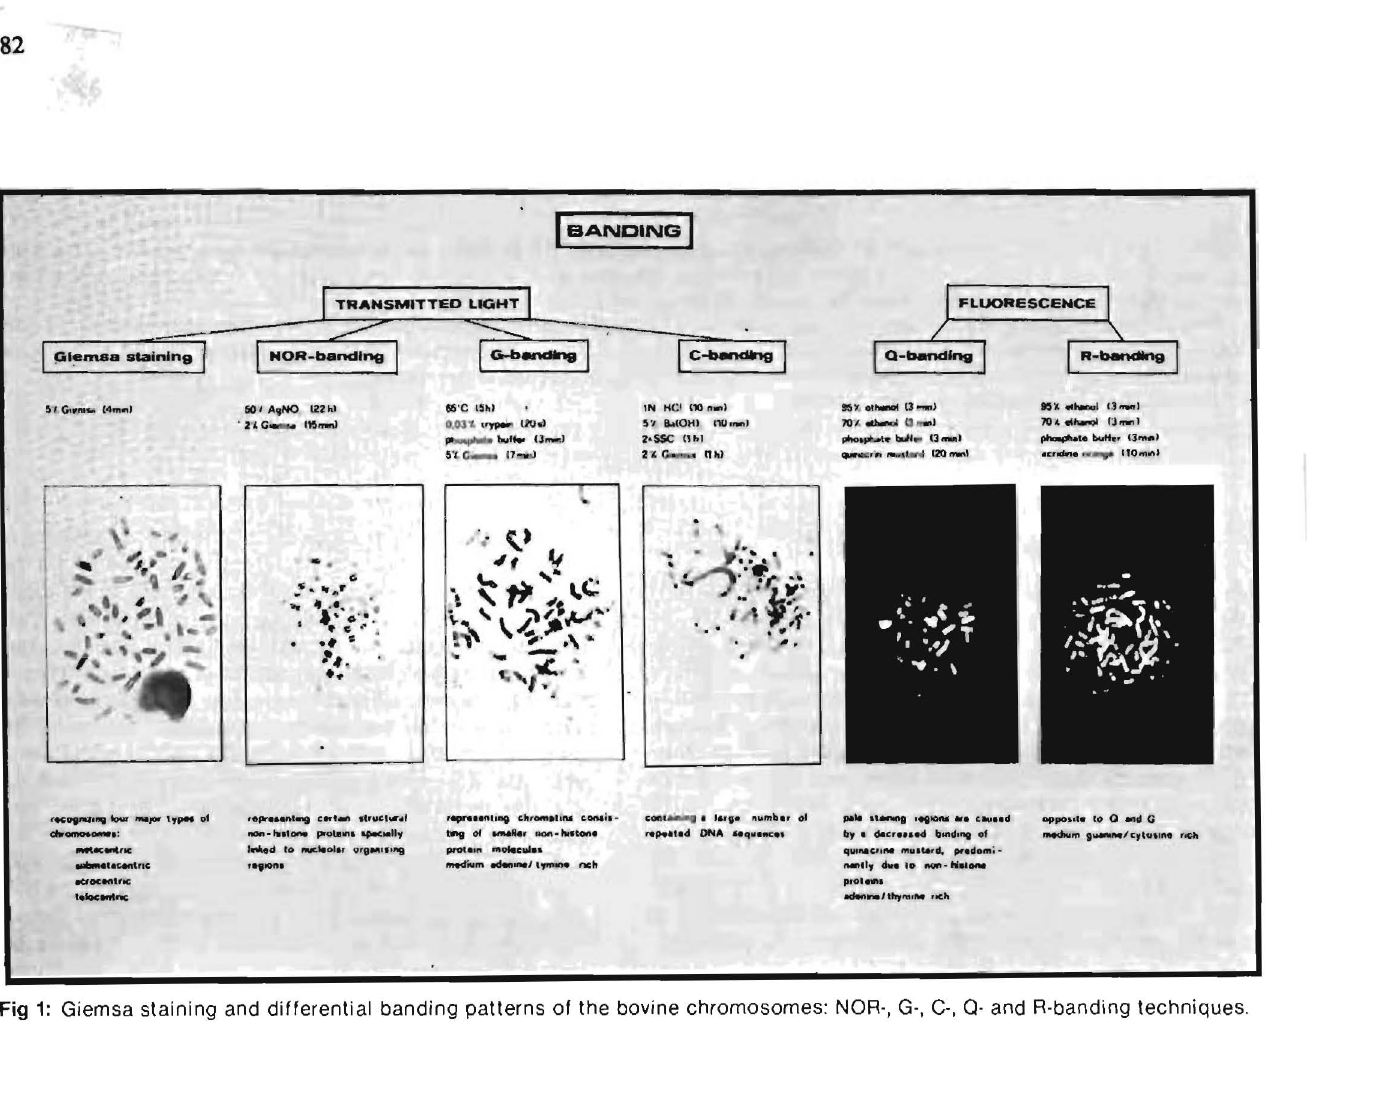
Fig 2: Representative G-banded karyotype of a Holstein/Friesian cow (2n = 60, XX).